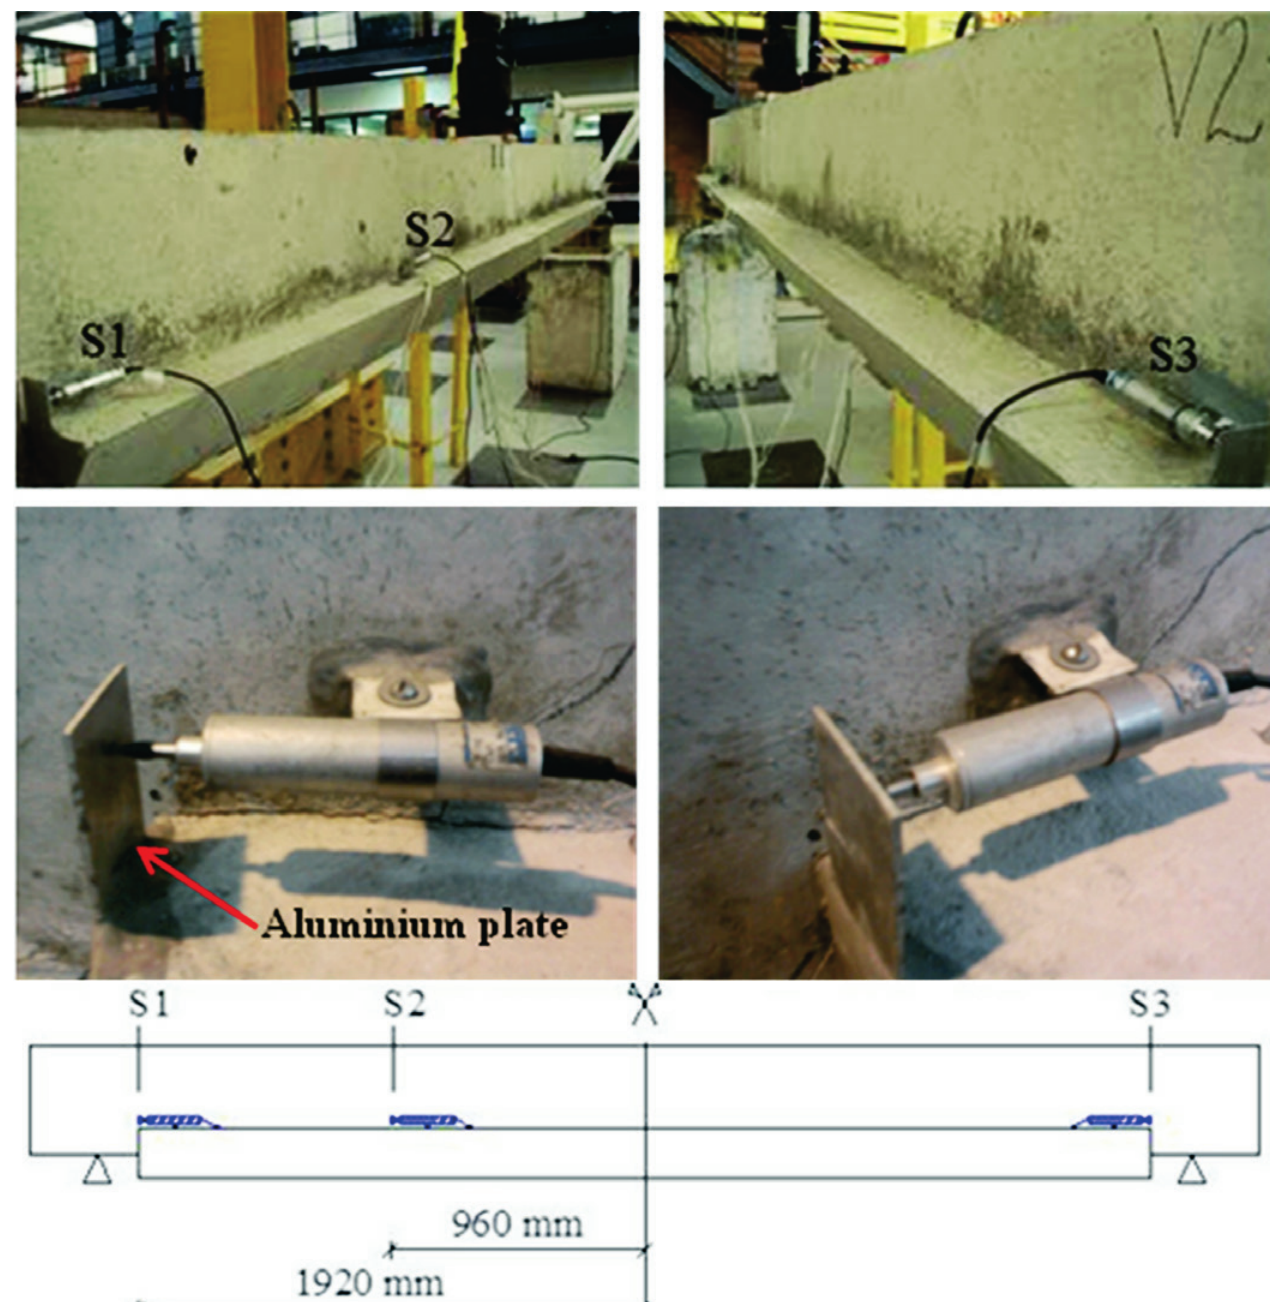
Position of displacement transducers for measurement of relative longitudinal displacements between beam and